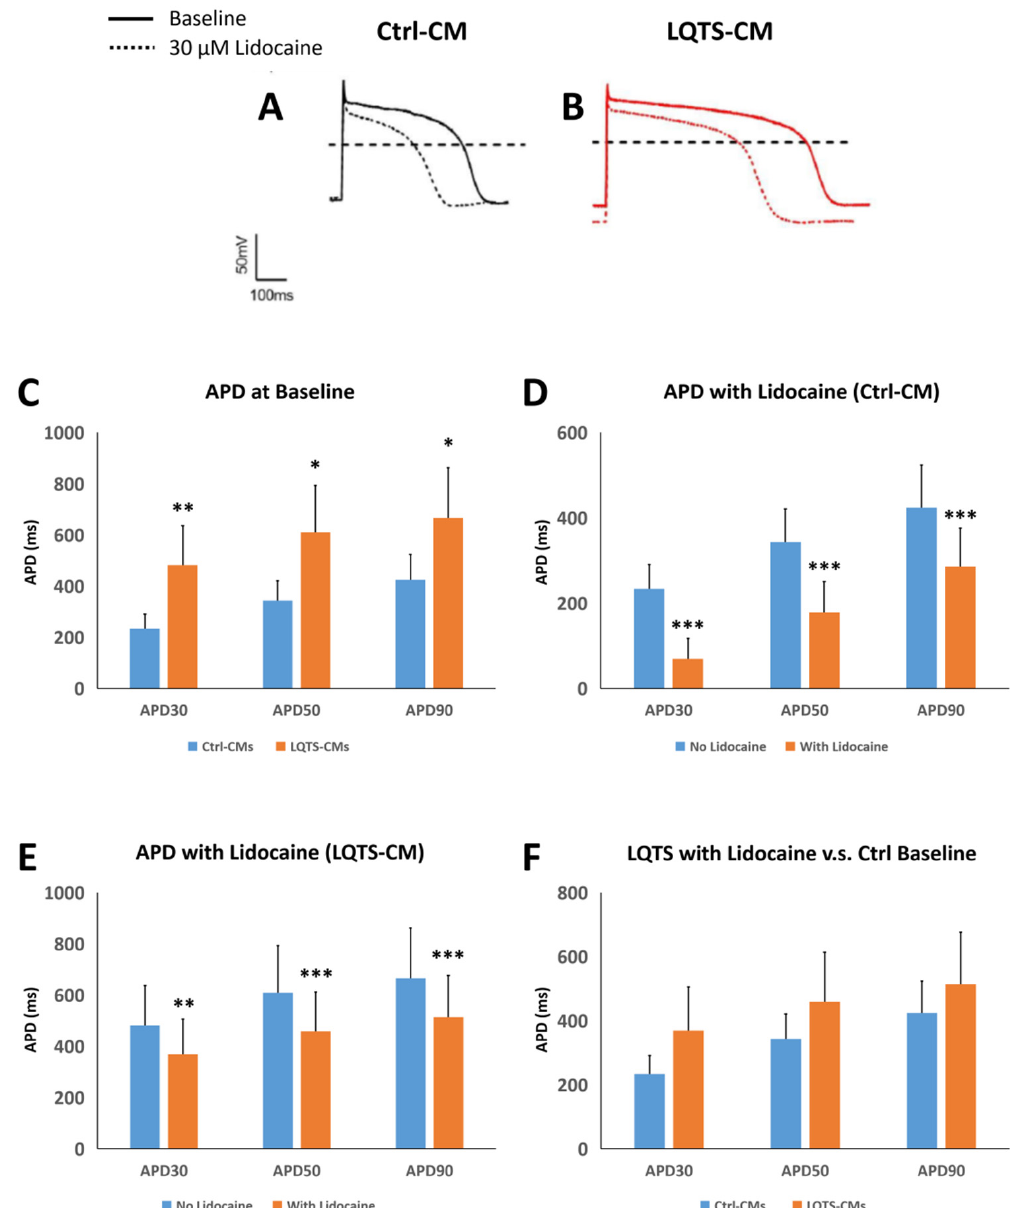
Figure 5. Electrophysiological Analysis of Lidocaine Treatment. Whole cell patch clamp revealed APD profiles of Ctrl-CMs ( A ) and LQTS-CMs ( B ), respectively. Without any treatment, LQTS-CMs demonstrated significantly longer QT intervals than Ctrl-CMs in terms of APD 30 , APD 50 and APD 90 ( C ). Treatment of 30 μ M lidocaine resulted in significant reduction of APD 30 , APD 50 and APD 90 in Ctrl-CMs ( D ) and LQTS-CMs ( E ). APD 30 , APD 50 and APD 90 of LQTS-CMs treated with 30 μ M lidocaine demonstrated no statistically significant difference when compared to APD values of Ctrl-CMs at baseline ( F ). Cardiomyocyte action potential graphs and immunofluorescence images are representative samples. All experiments were of n = 3 or larger. * = p ≤ 0.05; ** = p ≤ 0.01; *** = p ≤